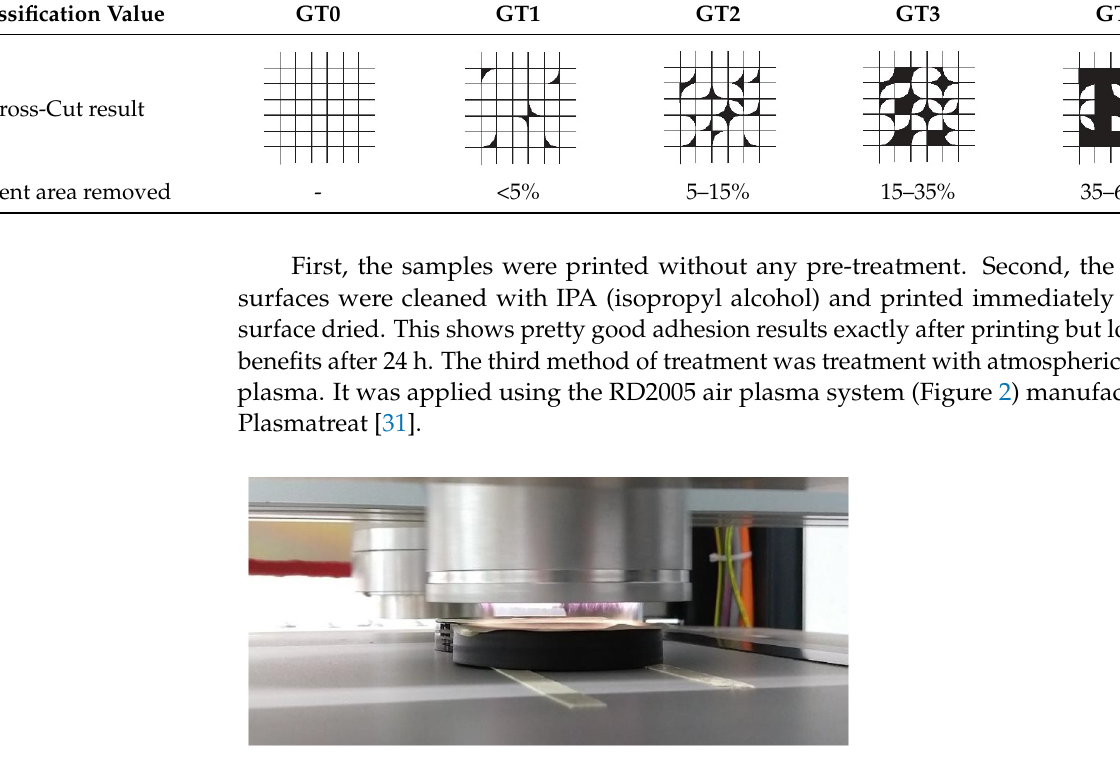
Table 3. Classification of Cross-Cut and tape test (DIN ISO 2409) results.